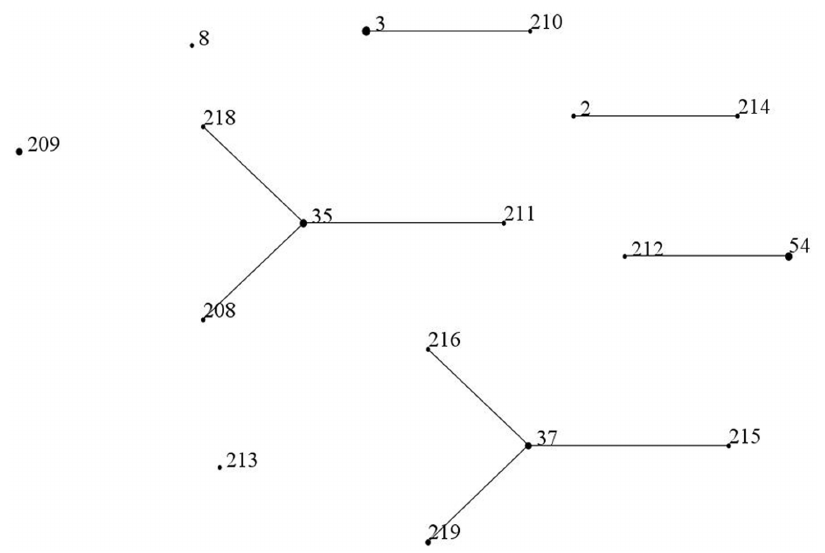
Figure 1. The relatedness of the STs seen in this study. The relatedness of STs were established using eBURST. ST209 and ST213 are a single- locus variant of ST5 and ST99,